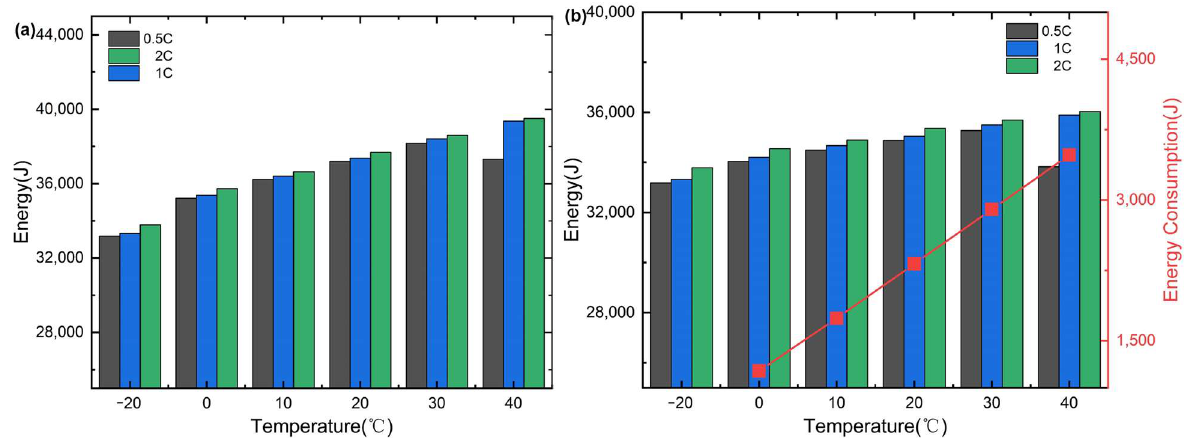
Figure 9. Histogram of energy. Heating energy consumption from ( a ) External; ( b ) Battery itself.